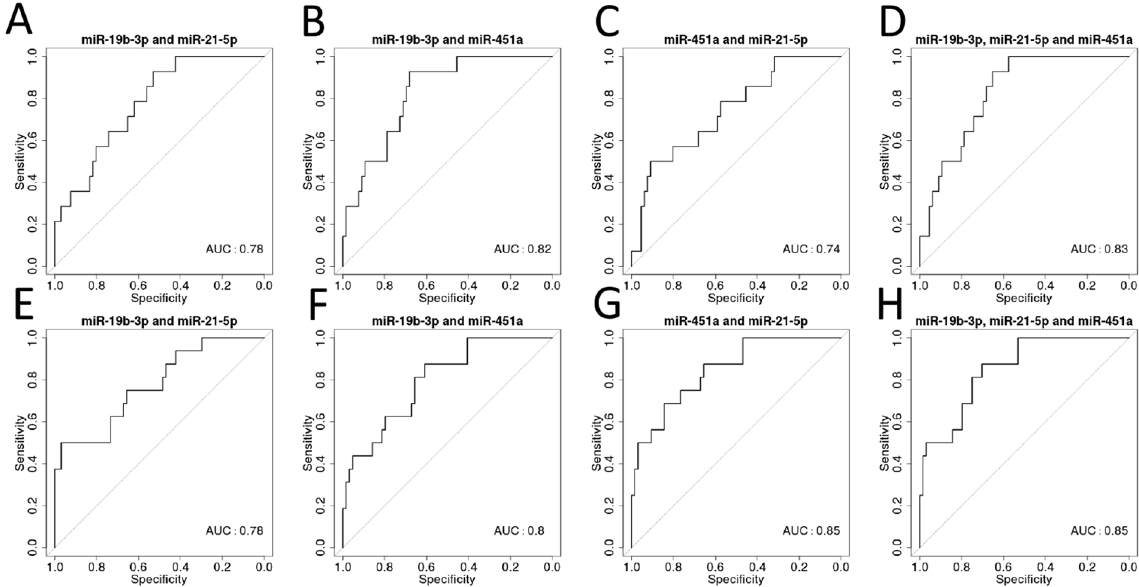
Figure 4. ROC analysis using binomial logistic regression to combine microRNAs for ( A – D ) TLE samples versus CH, CND and ( E – H ) SE samples versus CH, CND and TLE